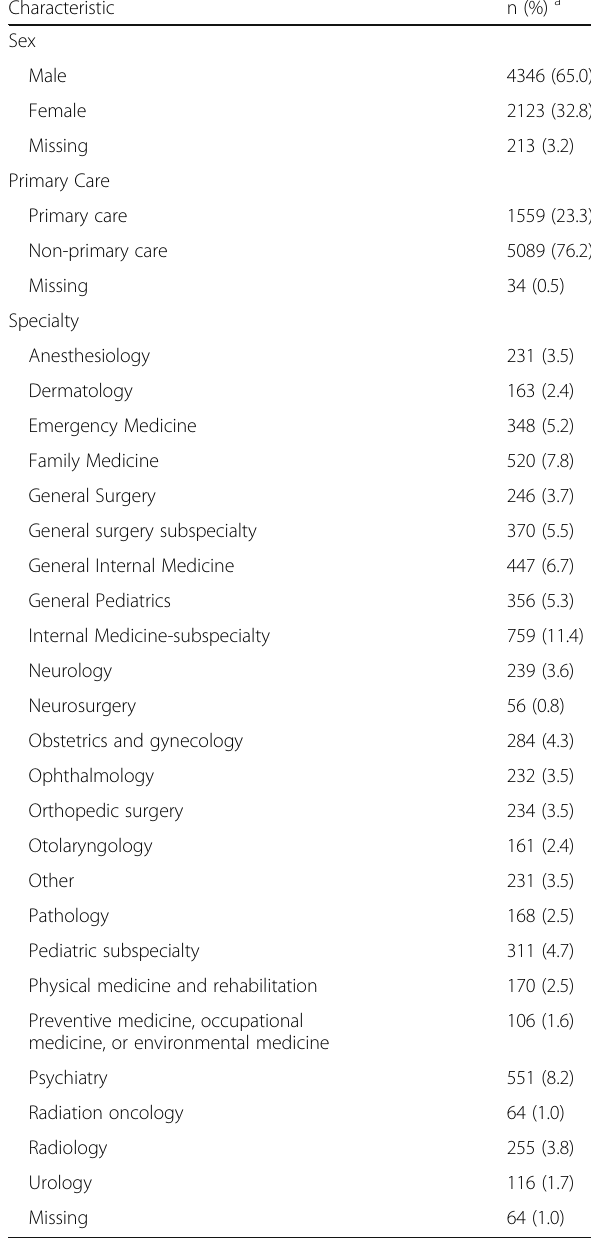
Table 1 MBI Overall Sample Characteristics ( n = 6682)